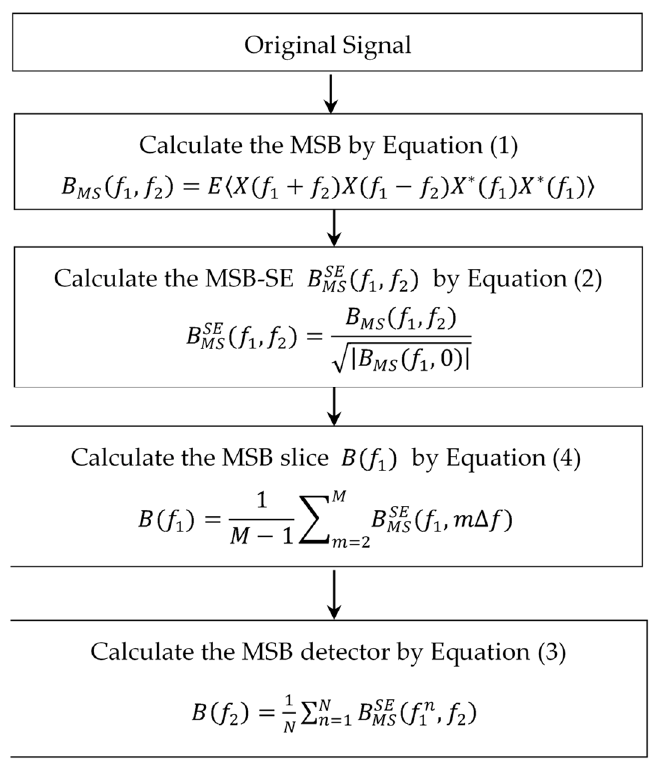
Figure 1. The flowchart of the modulation signal bispectrum (MSB) detector.